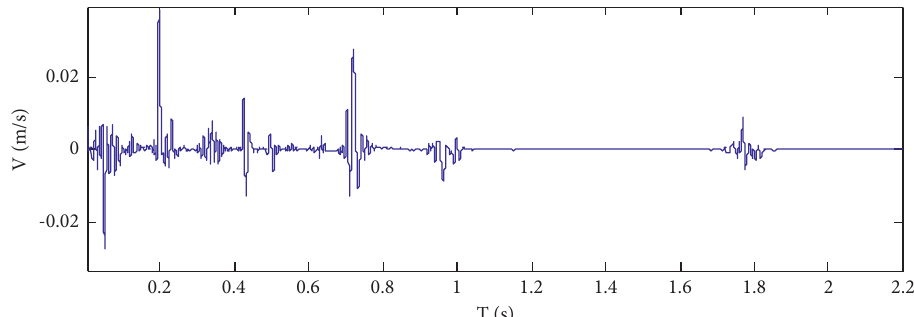
Figure 8: Waveform of filtered self-similar noise components after HHT